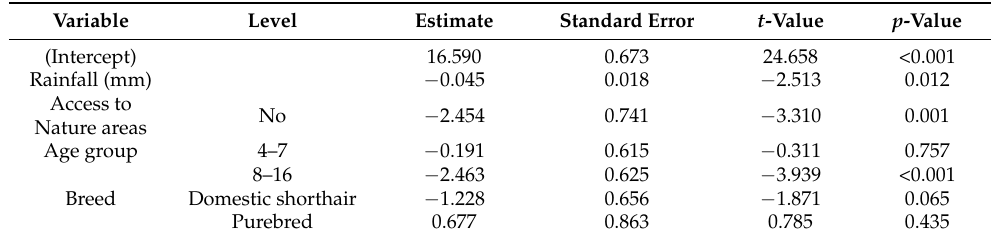
Table 2. Final model for cats’ daily distance moved (m). The R-square of the model was 0.59. The median for the standardised within-group residuals was 0.031, with a minimum of − 3.69, an IQR of − 0.49 to 0.54 and a maximum of 3.57. The reference category (intercept) consisted of cats of mixed/unknown breeds in the age group 1–3 years with access to nature areas.